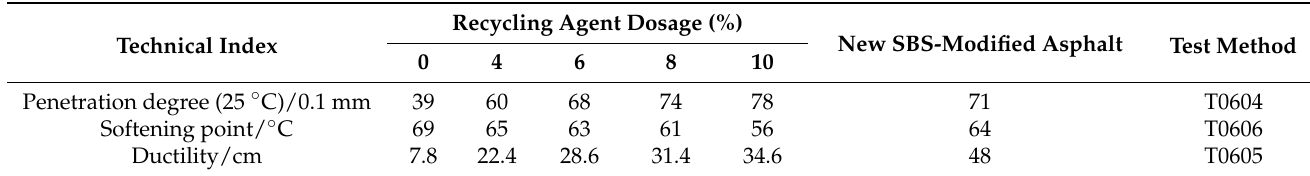
Table 7. Test results of rejuvenated asphalt.